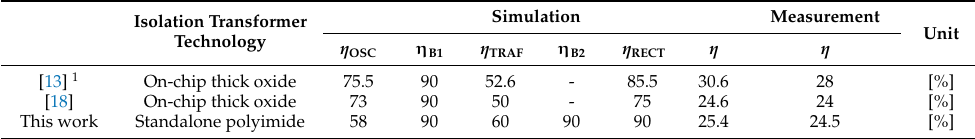
Table 5. Simulated power efficiency breakdown for galvanically isolated DC-DC converters. Isolation Transformer